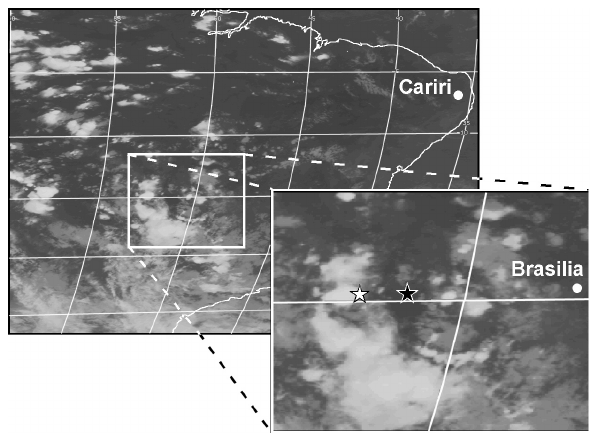
Fig. 10. GOES infrared satellite image showing the location of the convection over Brazil on the night of 01 October at 20:45UT. Note the absence of convection in the vicinity of Cariri. The stars in the enlargement show the results of ray tracing of the event #2 from Table 1 (Vadas et al.,